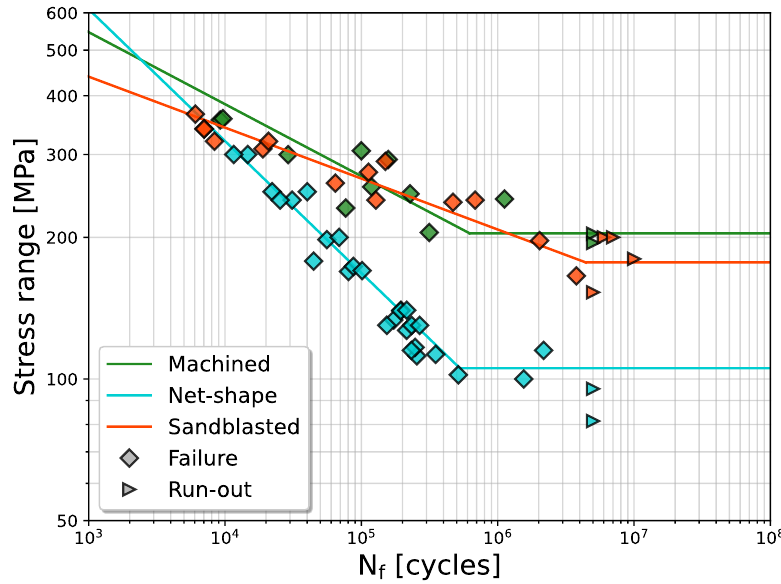
Figure 2. Comparison of the results of the fatigue tests of machined, sandblasted and net-shape axial specimens. Stress range has to be intended as maximum stress minus the minimum one during the fatigue cycle.